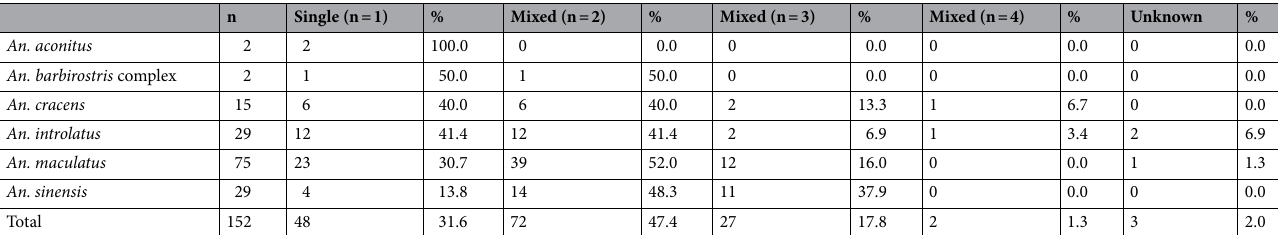
Table 1. Number of Anopheles mosquitoes with single and multiple blood